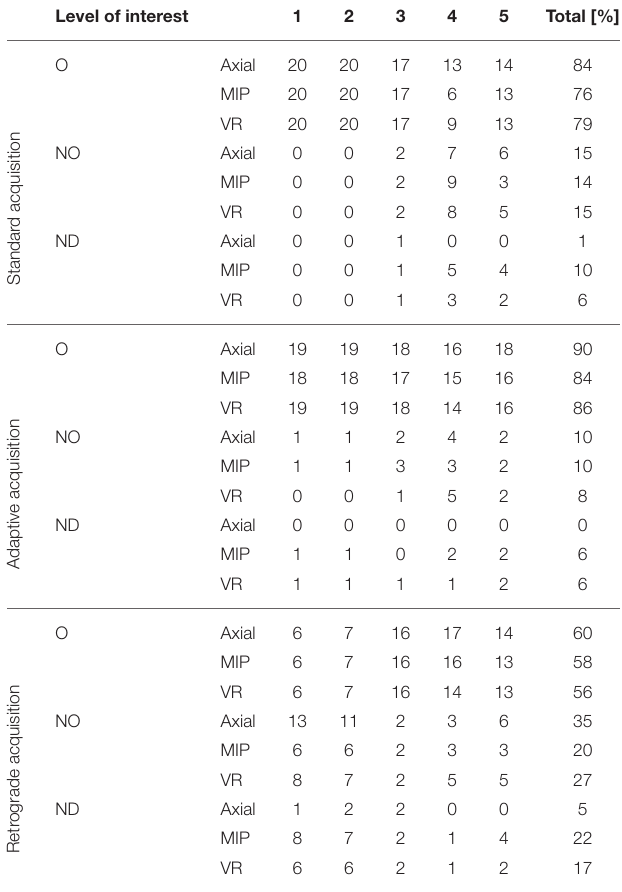
TABLE 5 | Number of optimal, non-optimal but diagnostic, and non-diagnostic segments at each level of interest for the three different acquisition techniques. Level of